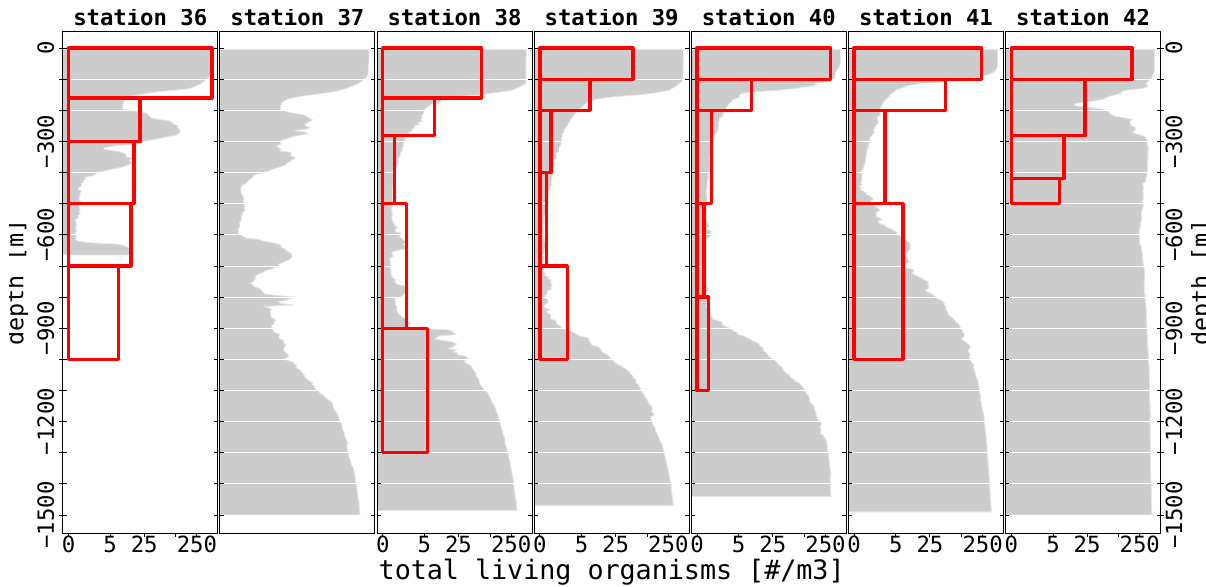
Figure 7. Vertical profiles of zooplankton abundance sampled with the multinet net (station 37 had no data), with oxygen concentration background (grey colour, for units see Fig. 4).